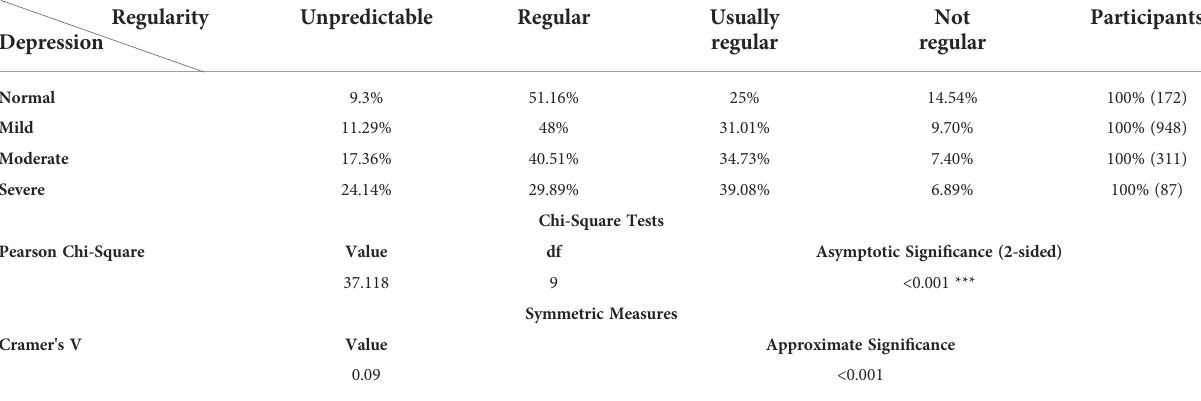
TABLE 2B Cross-tabulation analysis between the regularity of the menstrual cycle and BDI. Regularity